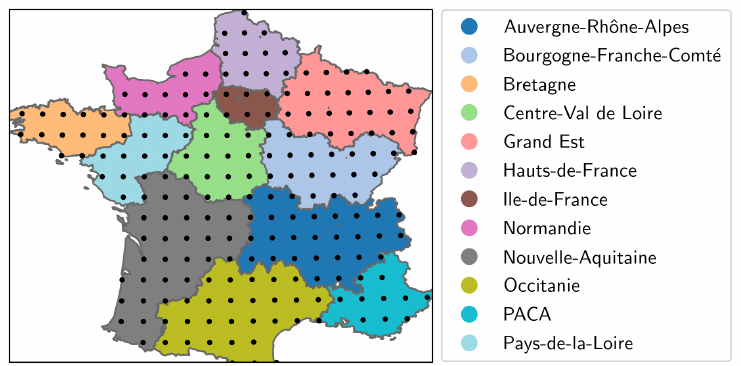
Figure 2. Assignment of the MERRA-2 climate-data grid points to the 12 regions of metropoli- tan